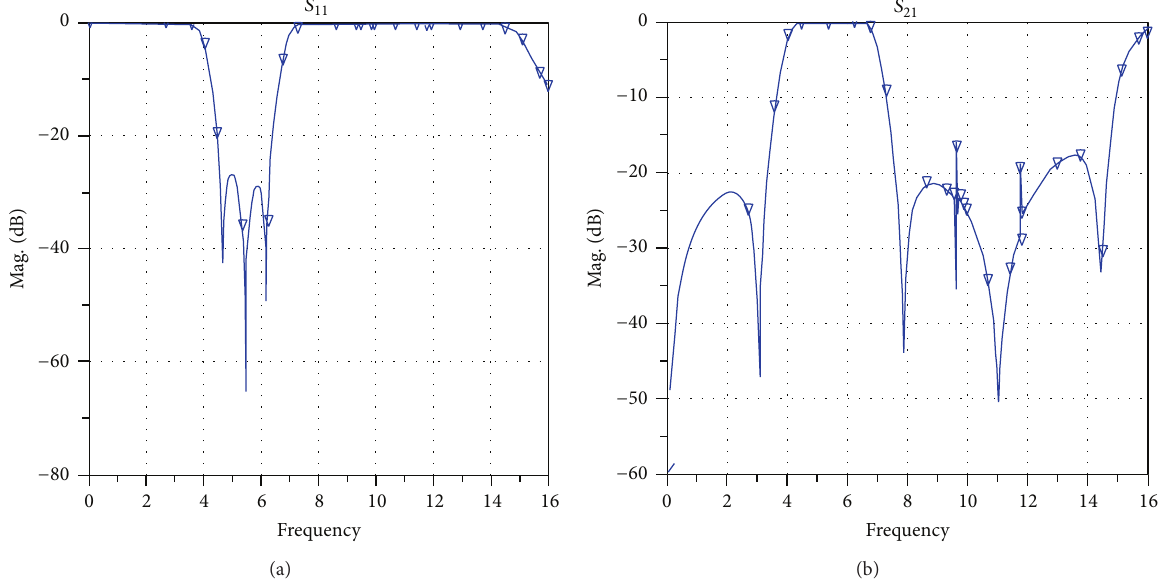
Figure 25: Simulated frequency response of the proposed new filter in the workspace of ADS plotted versus (a) return losses (𝑆 11 ) and (b) insertion losses (𝑆 21 ) .